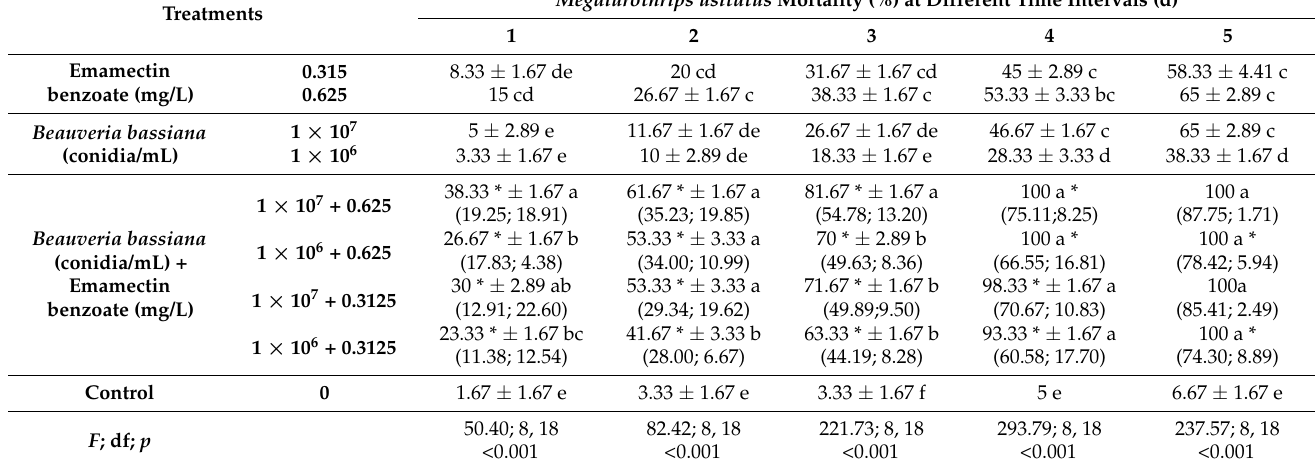
Table 1. Mortality (%) of M. usitatus in response to single or combined application of Beauveria bassiana and emamectin benzoate